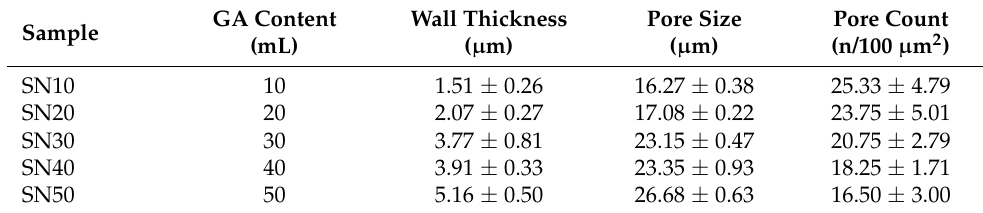
Table 2. Effect of GA content on wall thickness, pore size, and pore count of SN hydrogels prepared using a constant crosslinking time of 24 h and various GA